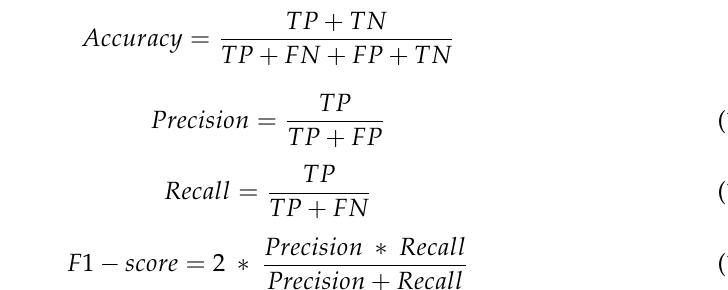
walking and sitting in Figure 9a,c still had large areas of blur and noise. Spectrograms